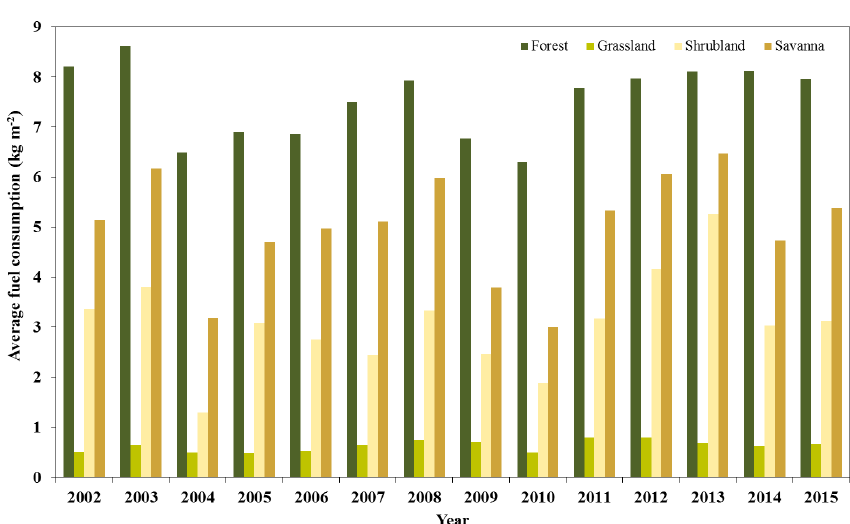
Figure 4. Average fuel consumption for different land cover types in northern Eurasia from 2002 to